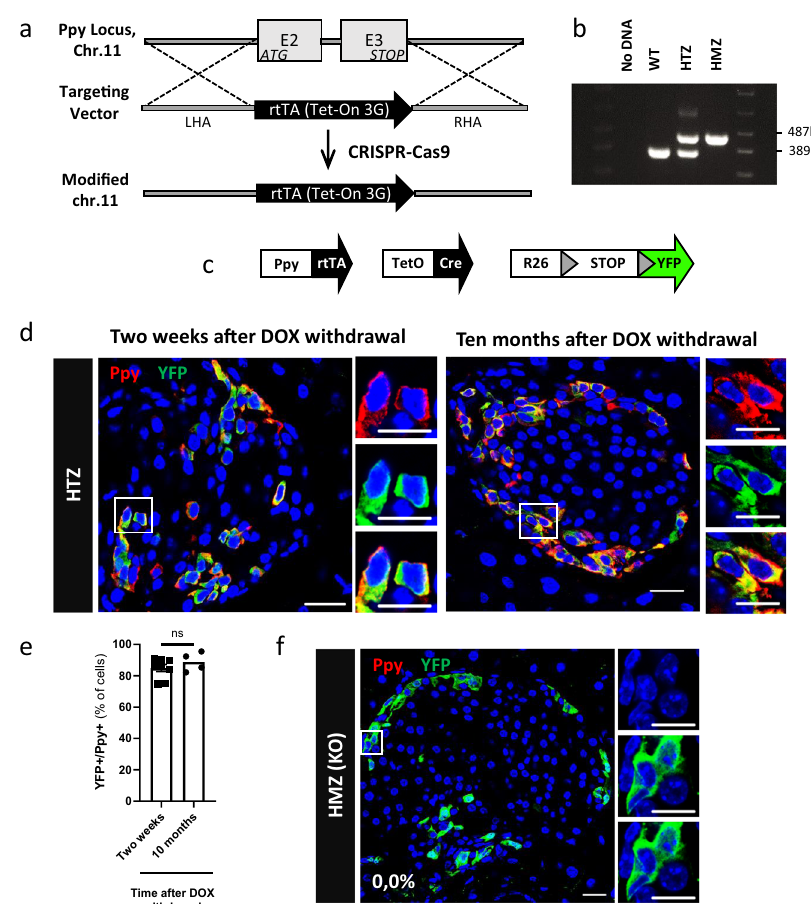
Fig. 1 Generation of knock-in mice to lineage-trace γ -cells and inactivate the Ppy gene. a CRISPR-Cas9 was used to replace the Ppy coding sequence (E2, E3: exons 2 & 3) on mouse chromosome 11 by the rtTA coding region ( “ targeting vector ” ). LHA left homology arm, RHA right homology arm. b PCR products of wild-type (WT), Ppy-rtTA heterozygous (HTZ) and Ppy-rtTA homozygous (HMZ) mice (WT band: 389 bp; KI band: 487 bp). “ No DNA ” is a negative control. Samples derive from the same experiment run at once in one gel. c Transgenes required for tracing the lineages of Ppy -expressing γ -cells. d Ppy + cells are ef fi ciently YFP-labeled two weeks or 10 months after DOX withdrawal in Ppy-YFPi mice. e Quanti fi cation of the YFP-labeled Ppy- expressing cells two weeks (84.9 ± 0.0, n = 8 mice, 5411 Ppy + YFP + out of 6389 Ppy + cell scored) or 10 months (88.8 ± 0.0%, n = 4 mice, 2852 Ppy + YFP + out of 2889 Ppy + cells scored) after DOX withdrawal. Data are shown as mean±s.e.m; two-tailed Mann – Whitney test ( P value 0.4606). f Ppy production is abrogated in Ppy-rtTA homozygous (HMZ, KO) mice: none of the YFP-labeled cells in DOX-treated animals (Ppy-YFPi, Ppy-rtTA HMZ) produces the peptidic hormone ( n = 3 mice; 0 Ppy + out of 1310 YFP + cells scored). Ppy (red) and YFP (green). Scale bars: 20 μ m (10 μ m in insets). Region of the pancreas: Ventral. Source data are provided as Source Data fi le (Supplementary Table